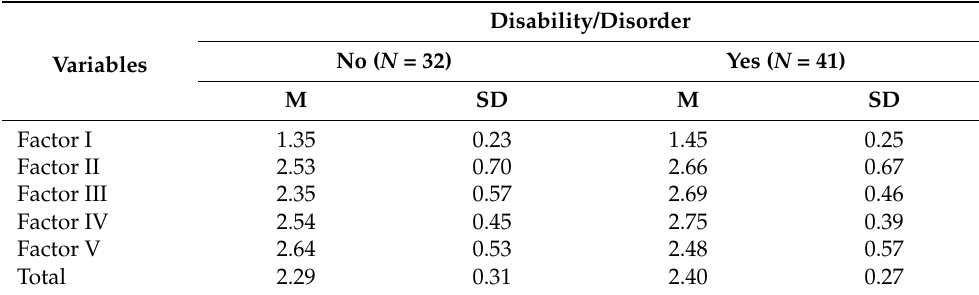
Table 6. Mean and standard deviation of perceptions of attention to diversity based on having or not having a disability.